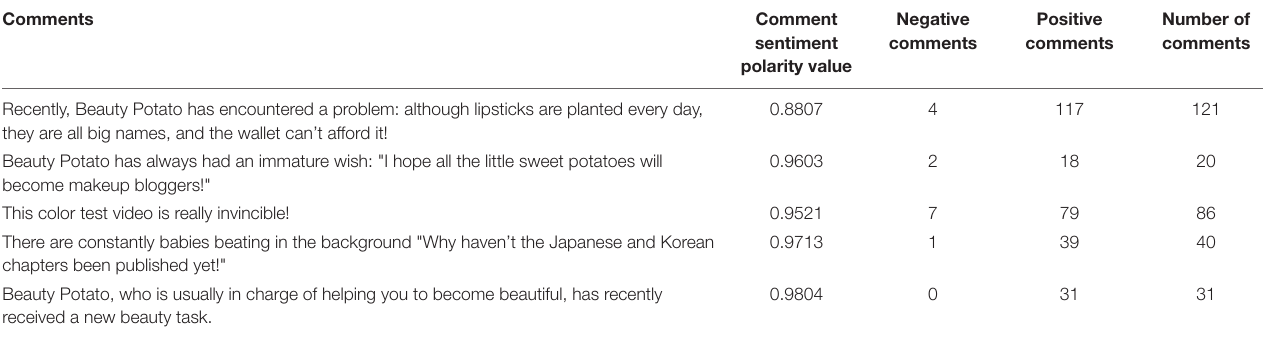
TABLE 3 | Sentiment polarity in the user’s “Jingdong” notes.